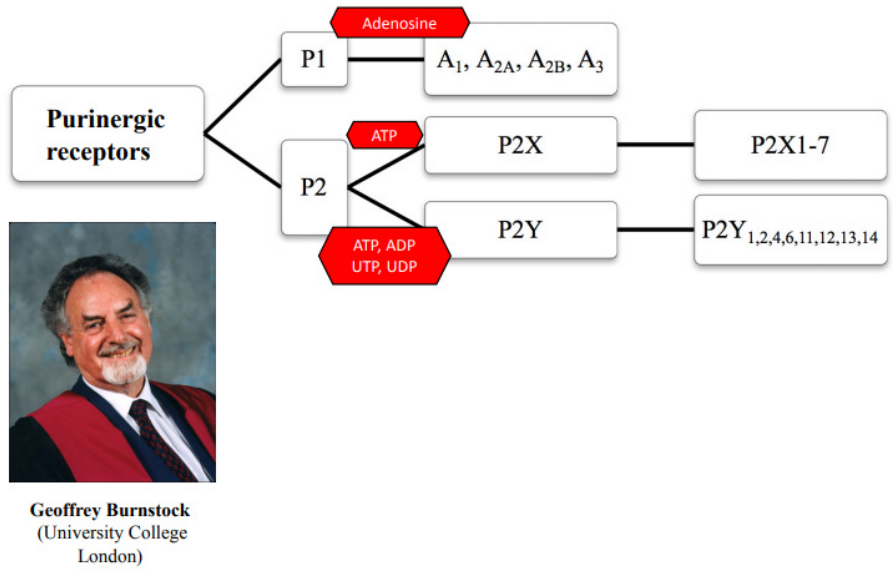
Figure 1. Classification of purinergic receptors. P1Rs consist of four subtypes and respond to the endogenous agonist adenosine. P2Rs consist of two subtypes, the ligand-gated cationic channels P2X (P2X1–7) responding to ATP only, and the G protein-coupled receptors P2Y (P2Y 1,2,4,6,11,12,13,14 ). The principal agonists of P2YRs are the following: ATP/ADP (P2Y 1,11,12,13 ), UTP/UDP (P2Y 2,4,6 ), and UDP-glucose (P2Y 14 ). Purinergic receptors were classified by the late Geoffrey Burnstock (see photo), together with his colleague Maria Pia Abbracchio